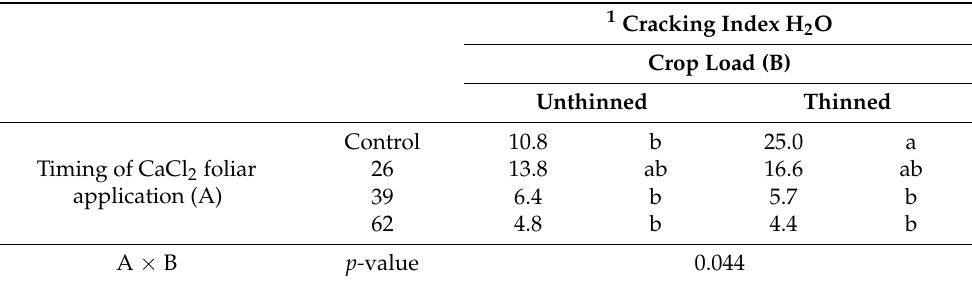
Table 8. Interaction between the timing of foliar CaCl 2 application (i.e., Control, and 26, 39, or 62 days after full bloom, DAFB) and crop load (i.e., natural crop load without fruit thinning vs. 50% of fruit removed) on the Cracking Index (CI) in the sweet cherry combination ‘Lapins’/‘Colt’.